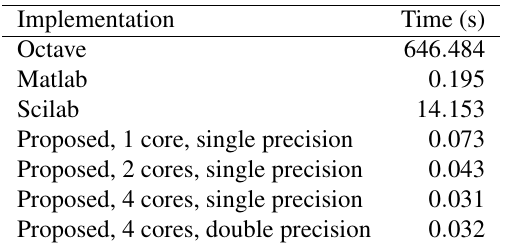
Table 1. Comparative results in composing 2 full 200 × 200 matrices.